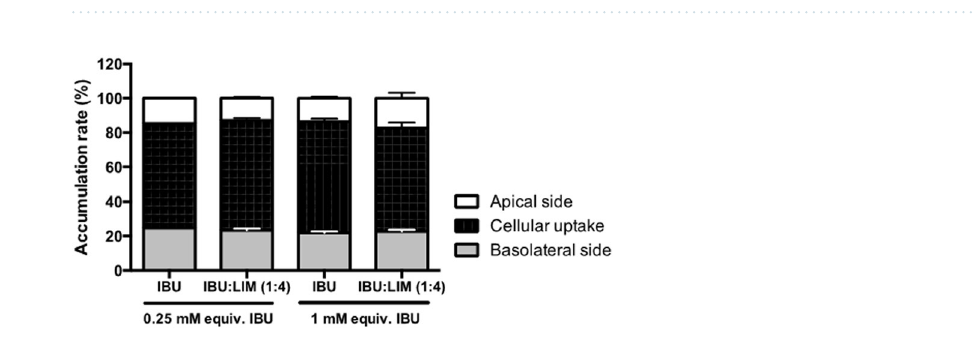
either equimolar or imbalanced. The formulation that led to a pasty-like solid at RT were readily discarded, such as the ones based on MA (C14). These data suggest that the size of saturated chain strongly influenced the supramolecular arrangements, and, consequently, the depression on the melting points of starting pure materi- als (Fig. 2A). The depression on the melting point is highly dependent on the nature of the counterparts, molar ratio, lattice energy of DES and also entropy changes arising from the supramolecular arrangements 1,38–40 . DSC analysis confirmed the results of simple naked-eye observation, as a small decrease on the melting point of MA was observed. Using a saturated fatty acid with lower chain size, such as CA (C10), in equimolar and imbalanced ratios after half an hour a clear and transparent liquid was obtained at RT which was reflect by a depression on the melting point of CA. Using menthol as counterpart of LIM a transparent liquid was obtained at all the molar ratios, and the thermograms reveal the inexistence of any sharp peak of the menthol polymorphs (i.e., ≈ 28 °C and ≈ 33 °C). These peaks have been ascribed to alpha and beta polymorphs, being in good agreement with the literature 41–43 . Upon combining IBU with LIM at equimolar and imbalanced molar ratios up to 1:3, a slight depression on the melting point of IBU was observed, which suggested that depending on the molar ratios the shift is clearly different as one component will be in excess or default to stablish the intermolecular interactions. Using a molar ratio of 1:4 a strong depression on the melting point was observed and doubling the molar ratio the peak ascribed was completely suppress. Thereby, these molar ratios were the only ones that succeed in the forma- tion of a liquid at RT and or near physiological temperature. It should also be noted that the thermograms of each